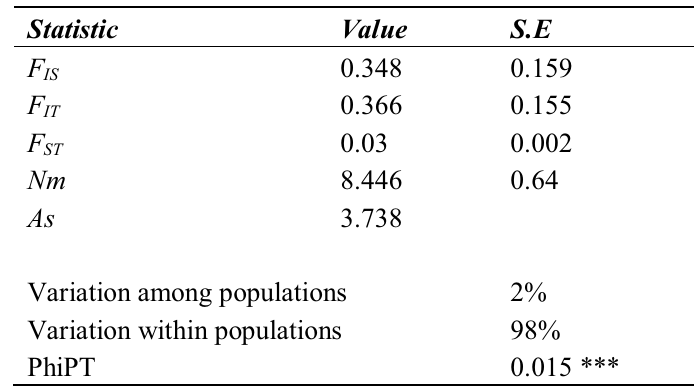
Table 5. Summary of species level diversity and partitioning of genetic variation across ten microsatellite loci and among eight H. canterburyana sites. Wrights F statistics ( F ), past gene flow among population ( Nm ), the mean number of alleles per locus within F ST the species ( As ). In addition the results of an ANOVA analysis are given where the % of variability within and between population is given and the test statistic PhiPT significance values *** p < 0.001.